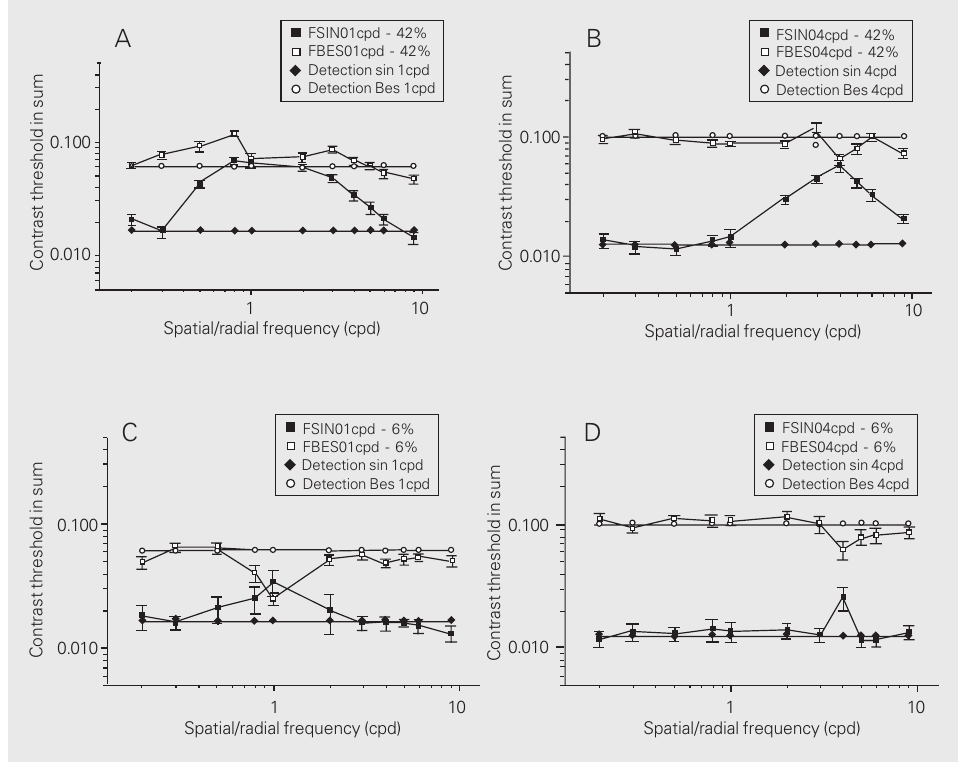
Figure 3. Contrast thresholds of test frequency in the summed stimuli obtained with the standard low-contrast resolution monitor. A , Grand mean of contrast at threshold in sum for the test frequency used to estimate FSIN01cpd and FBES01cpd with background frequency contrast fixed at 42%. Horizontal lines are detection thresholds for the 1.0 cpd sine-wave grating and for the 1.0 cpd radial frequency. Note the difference in